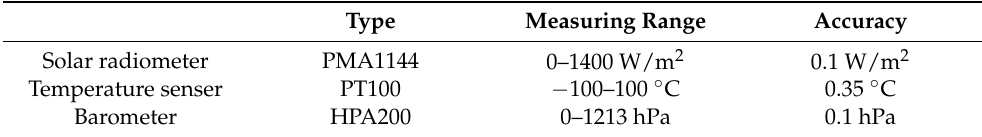
Table 1. Table of sensors’ parameter and accuracy.